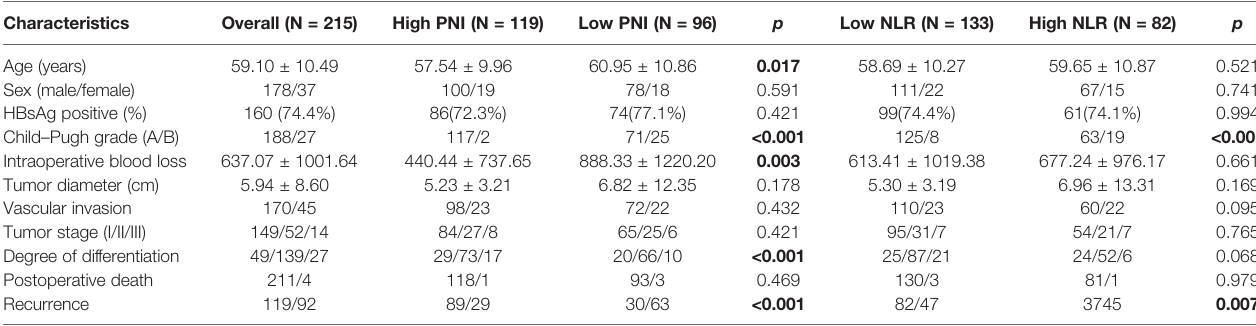
TABLE 2 | Clinicopathological characteristics of the patients and clinicopathological correlations of in fl ammatory indices.